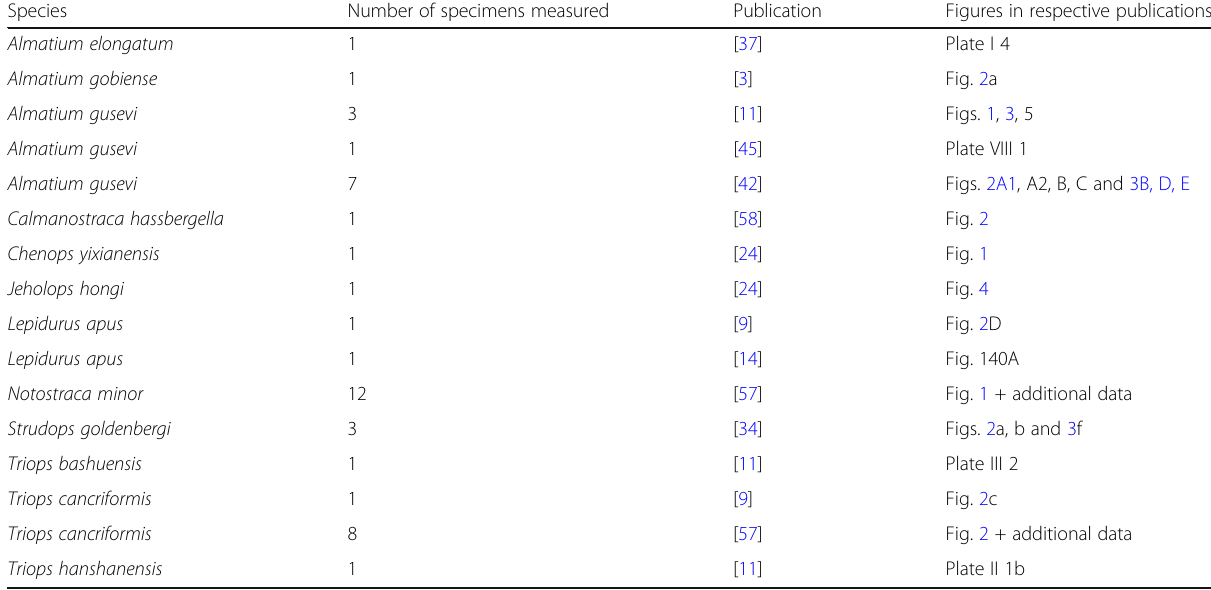
Table 1 Measurements performed on published data. Table gives publication and respective figure within the paper used for